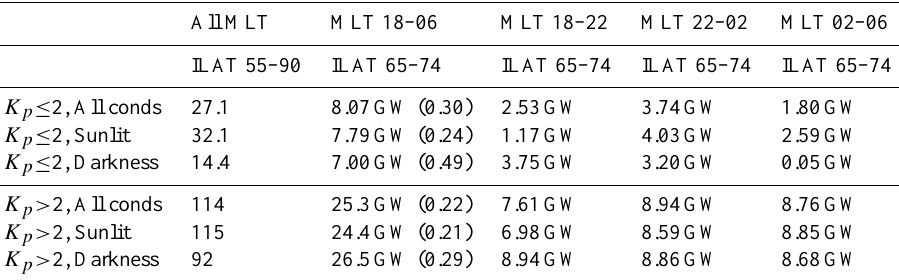
Table 4. Total Joule heating in designated region. The first column shows the total global (ILAT 55–90) Joule heating. This can be compared with the total nightside auroral zone Poynting flux (column 2). In parentheses the portion of Joule heating going into the nightside auroral zone relative to the total global Joule heating is shown. In columns 3–5 the total auroral zone related Joule heating is given for each nightside MLT